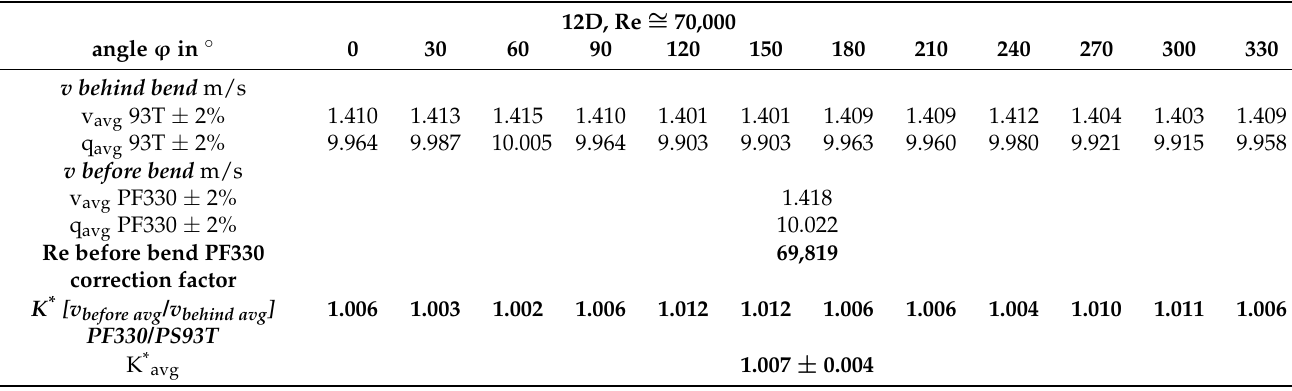
Table 9. Summary of the results of ultrasonic measurements for the 12D plane from the disturbing element as a function of the mounting angle of the ultrasonic flow meter heads, Re ∼ = 70,000.